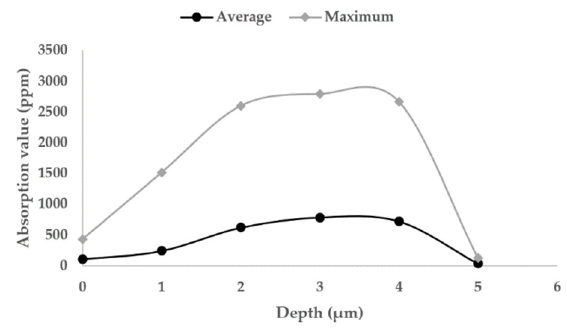
Figure 8. The peak and average absorption of damage.